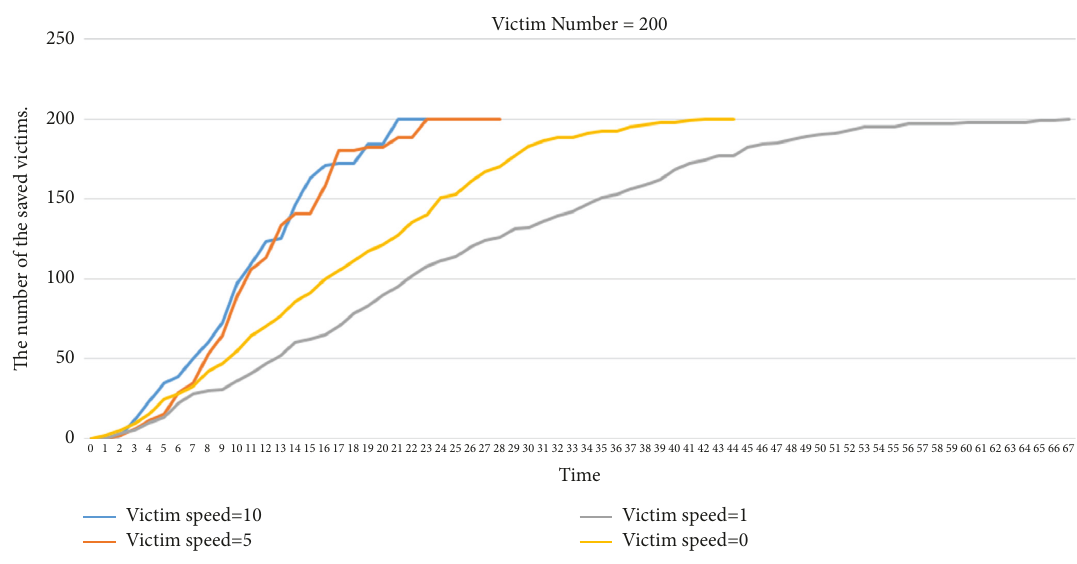
Figure 13: The number of the saved victims over time (victim number �